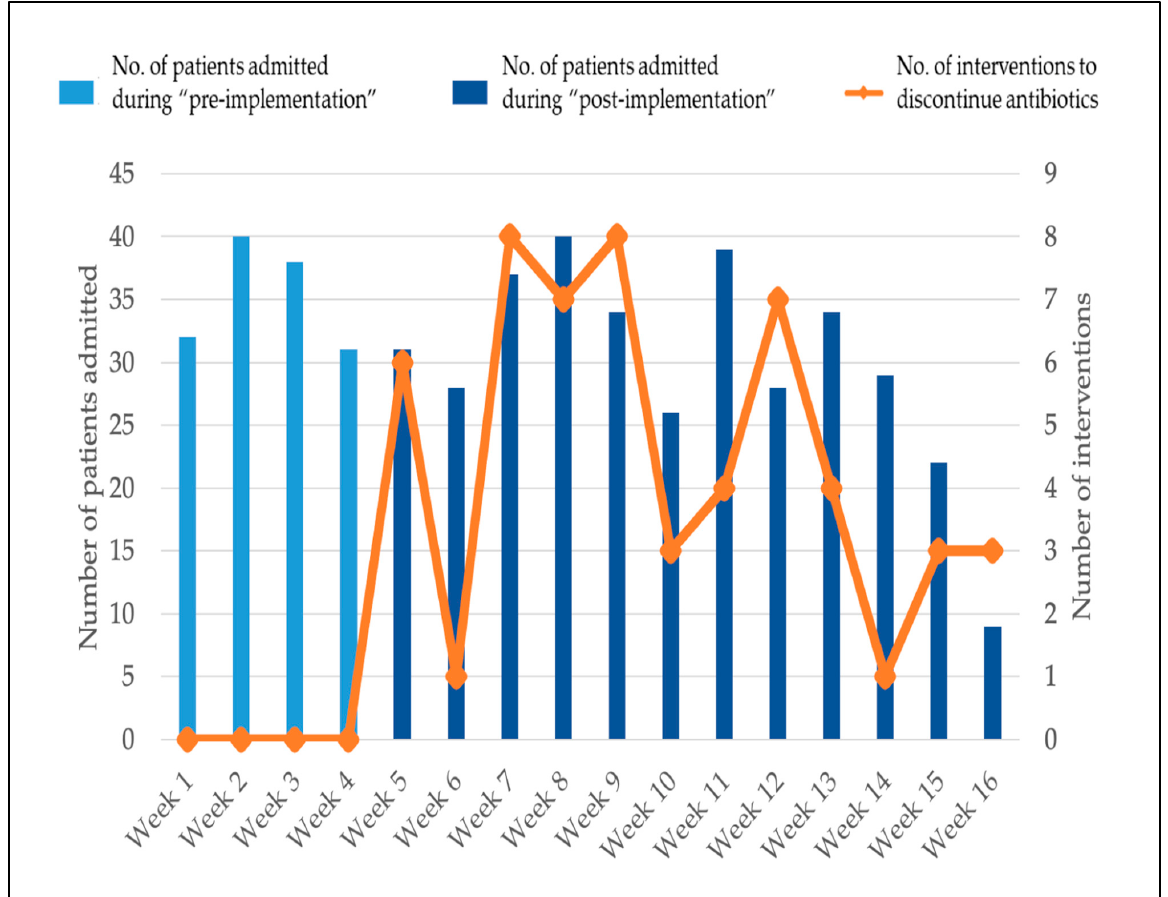
Figure 2. Weekly number of patients admitted to the RSWs who fulfilled study criteria (left axis) and the weekly number of ASU interventions made to discontinue antibiotics (right axis). Audit of CAP antibiotics were not performed in the “pre-implementation” period (Weeks 1 to 4) and there were no stewardship interventions placed during that time.